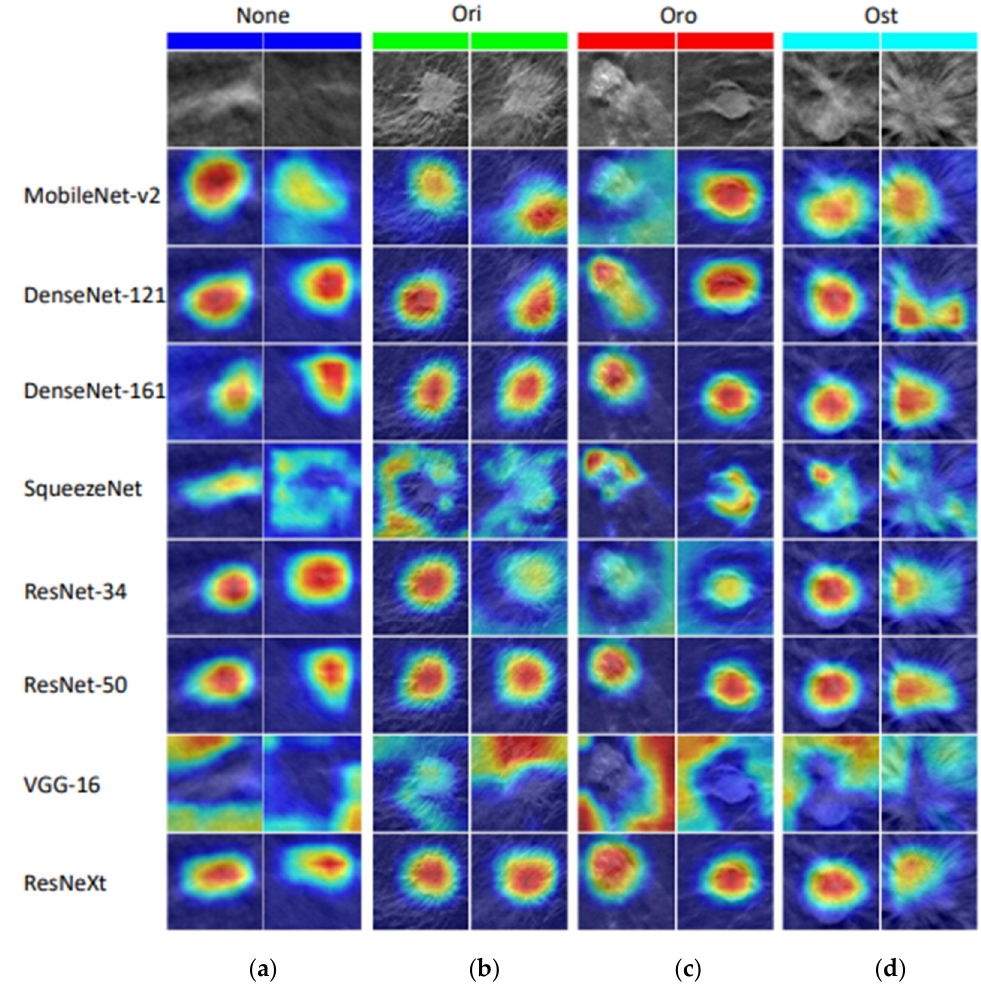
Figure A3. GRAD-CAM Region of Interest (ROI) images for ( a ) No lesions (None); ( b ) Irregular opacity (Ori); ( c ) Regular opacity (Oro); and ( d ) Stellar opacity (Ost). Thus, it can be noticed that graphical reasoning has good understanding in the CAM- based interpretations, whereas the evaluation of LIME and GRAD-CAM activation maps are completely different which can be noticed from Figures A2 and A3. Ultimately, it is recommended to consider both interpretations and models evaluation to gain a broader view of this process.